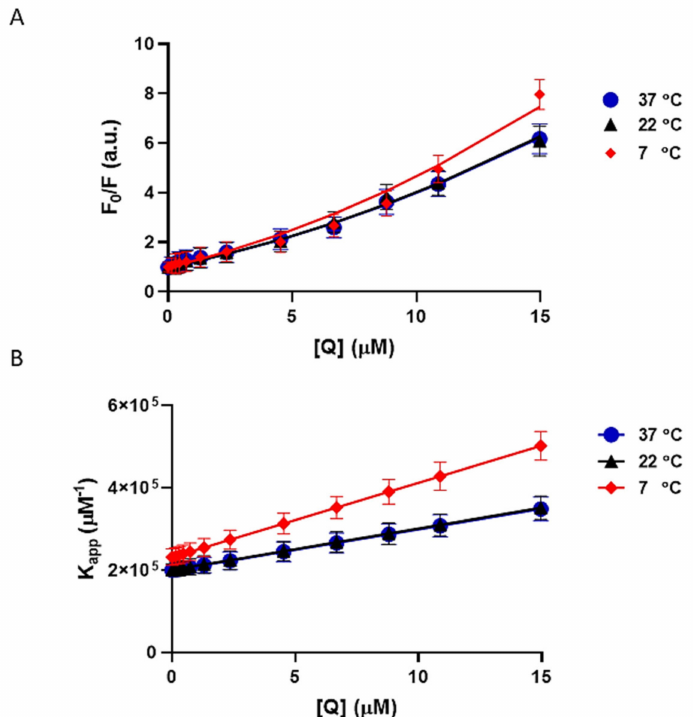
Figure 6. Modified Stern-Volmer plots of tau-CBD at 7 ◦ C, 22 ◦ C, and 37 ◦ C. All data points are given as the mean ± SD of three independent experiments ( n = 3). ( A ) Modified Stern–Volmer plot of tau protein fluorescence quenching at different concentrations of CBD from 0–14.9 µ M (0 µ M, 0.45 µ M, 1.3 µ M, 2.3 µ M, 4.5 µ M, 6.7 µ M, 10.9 µ M, and 14.9 µ M) at 7 ◦ C, 22 ◦ C, and 37 ◦ C. The data points are the results of the quenching experiment and the corresponding regressions are shown as